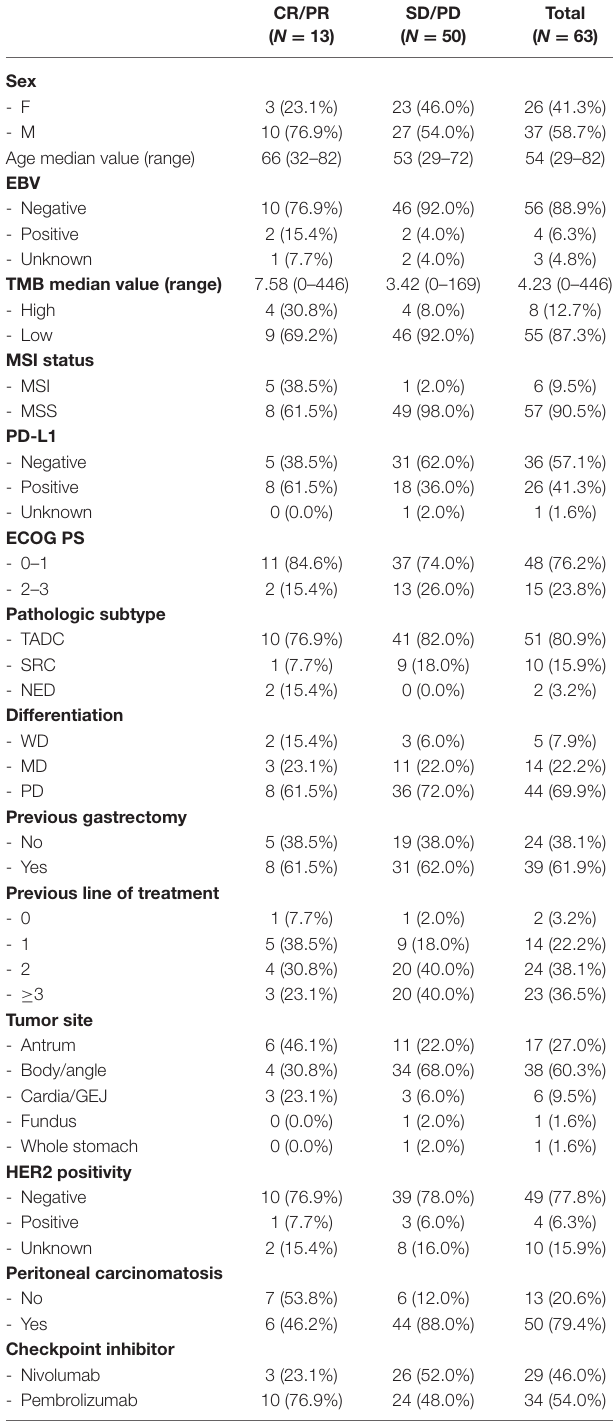
TABLE 1 | Patient